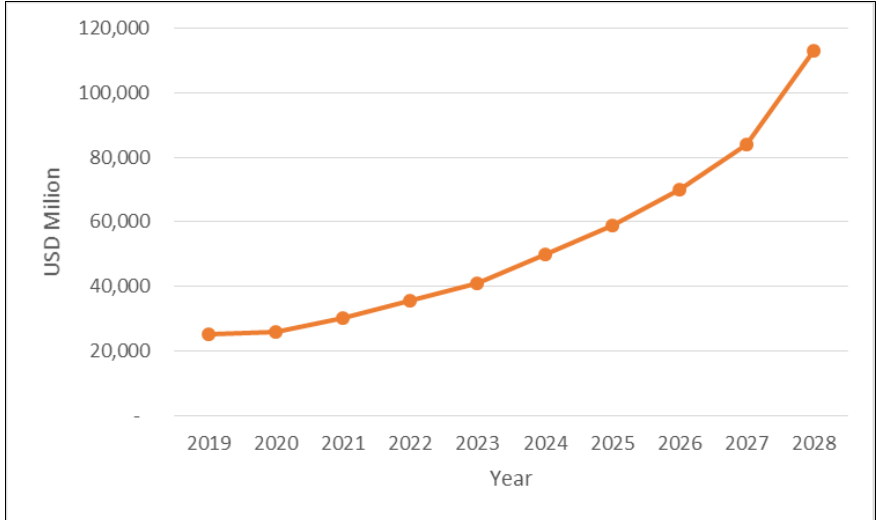
Figure 4. Value of global electric bus market, 2019–2028